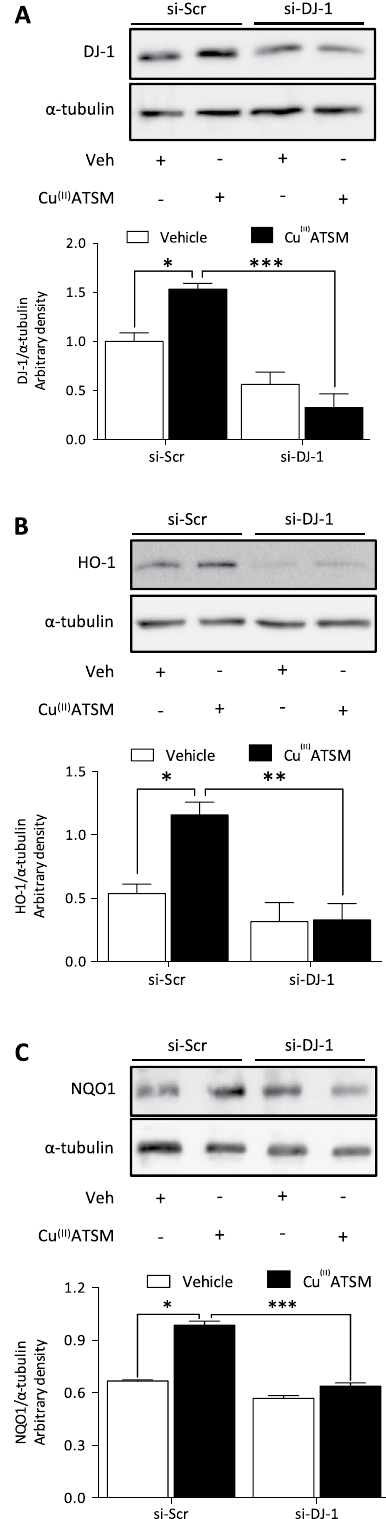
Figure 4. Cu (II) ATSM mediated induction of HO-1 expression in HCASMC is dependent on DJ-1. Induction of ( A ) DJ-1, ( B ) HO-1 and ( C ) NQO1 by Cu (II) ATSM (1 µ M, 12 h) was assessed in HCASMC transiently transfected with scramble (Scr) si-RNA or DJ-1 si-RNA, and expression determined by immunoblotting relative to α -tubulin. Data denote mean ± S.E.M., n = 4, P < 0.05, ** P < 0.01, *** P < 0.001 (two-way ANOVA and Bonferroni post hoc